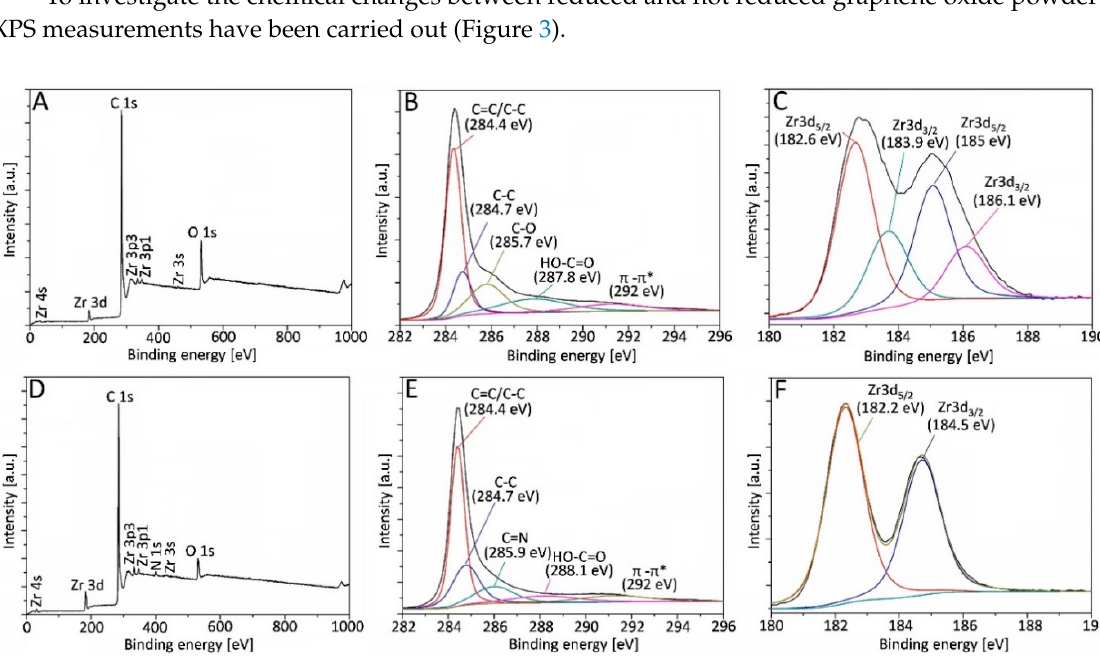
Figure 3. Survey XPS spectra ( A , D ), fitted spectra of C1s ( B , E ) and Zr3d ( C , F ) detailed scans for ZrO 2 /GO (upper row) and ZrO 2 /rGO (bottom row) powders.